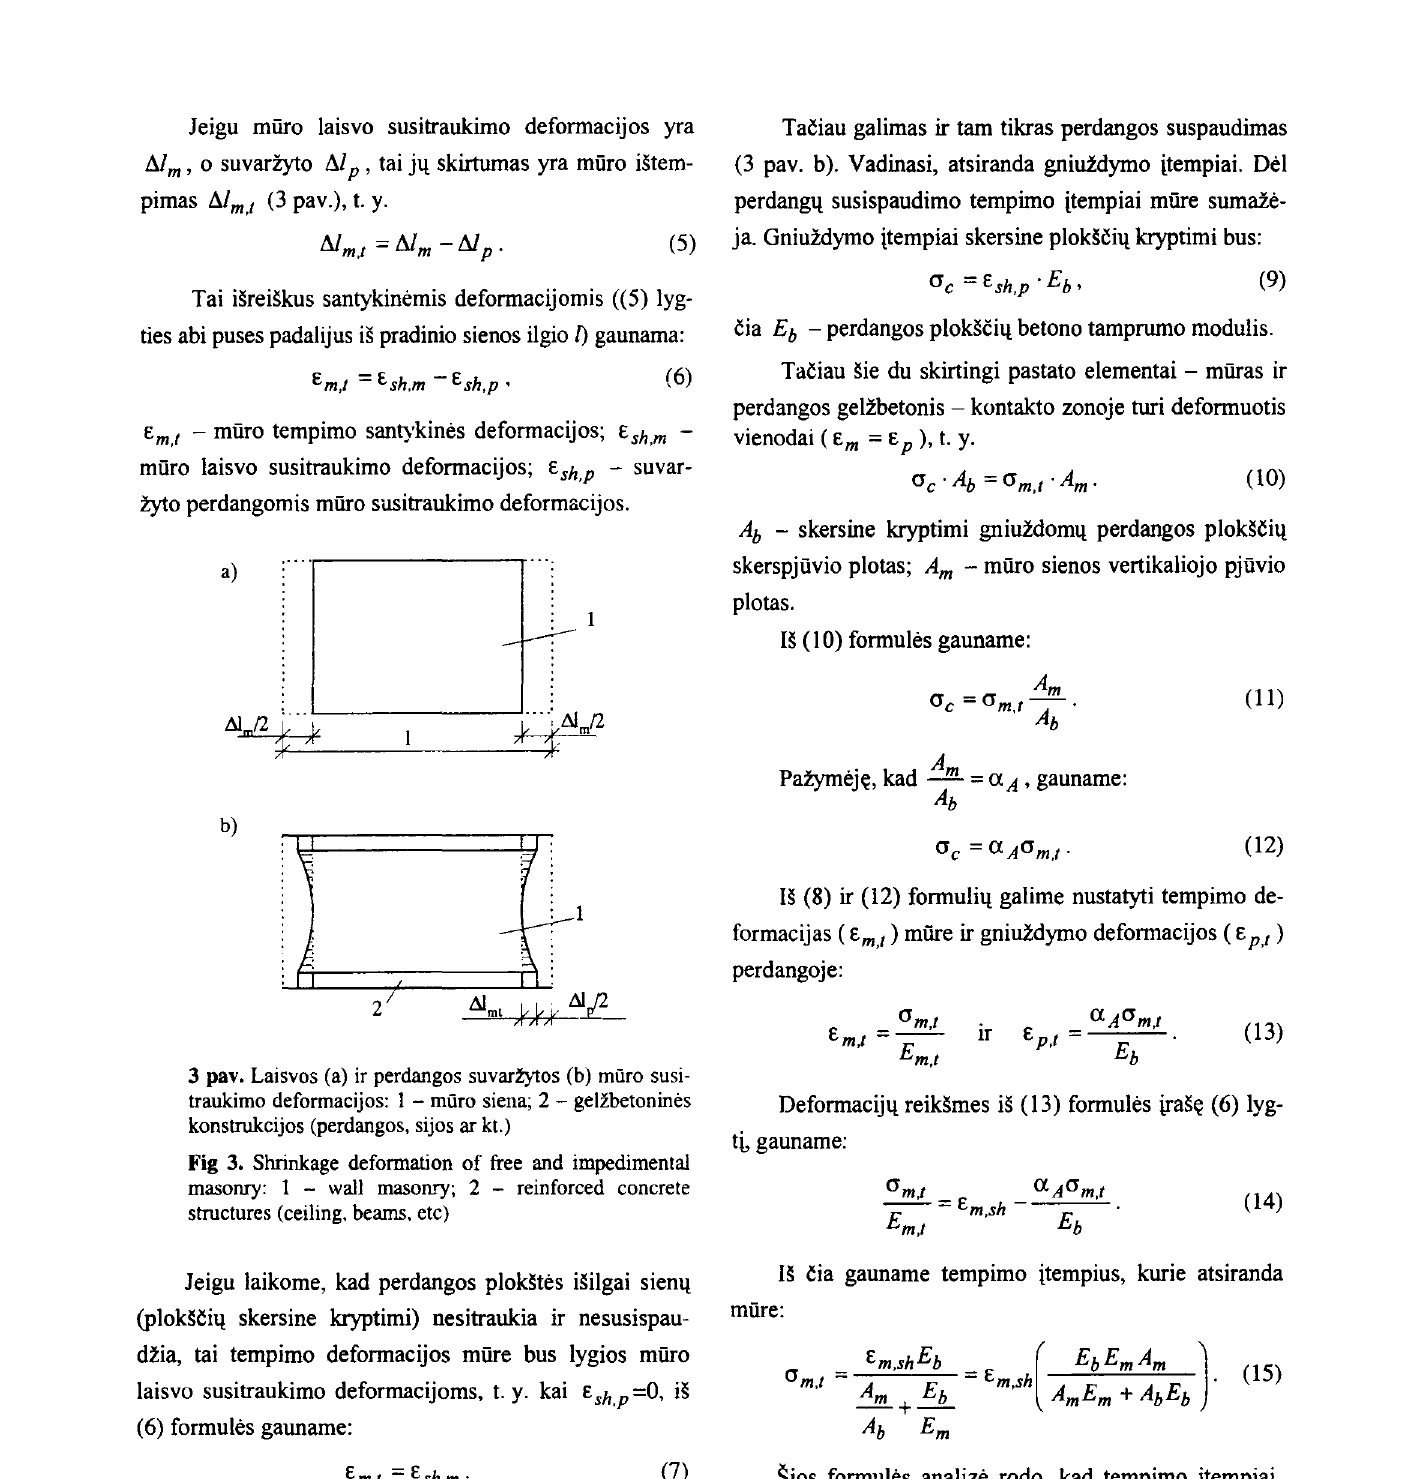
Fig 3. Shrinkage deformation of free and impedimental masonry: 1 - wall masonry; 2 - reinforced concrete structures (ceiling, beams. etc) Jeigu laikome, kad perdangos plokstes isilgai sienq (ploks6q skersine kryptimi) nesitraukia ir nesusispau dzia, tai tempimo defonnacijos miire bus lygios miiro laisvo susitraukimo defonnacijoms, t. y. kai Esh,p=O,